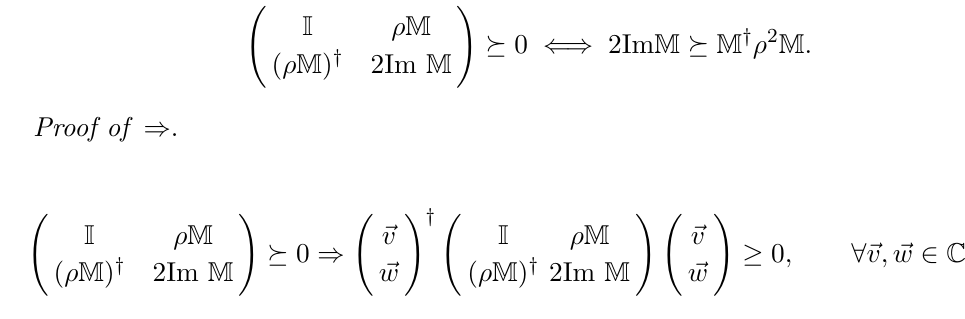
Figure 24. Space of allowed couplings compatible with spectrum as in table (1). The tip of this spear is the thermal deformation of the Tricritical Ising